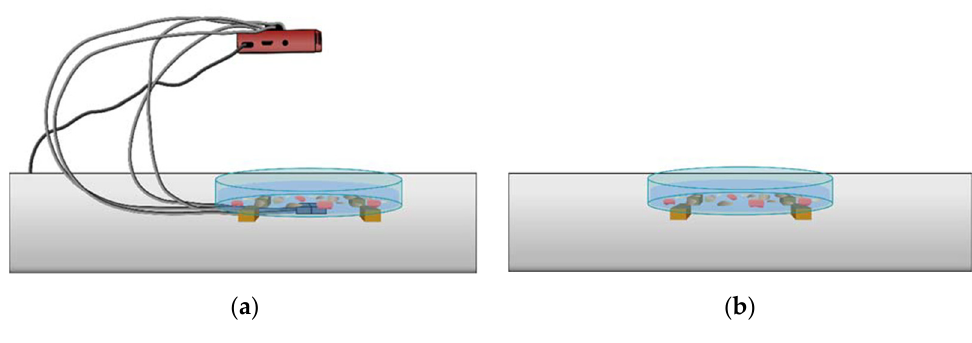
Figure 5. Sample under acoustic wave stimulus ( a ) and control sample ( b ). At the end of the treatment, after ninety minutes, the seeds of the control and sound wave-treated samples were dried thoroughly with absorbent paper and weighed again.